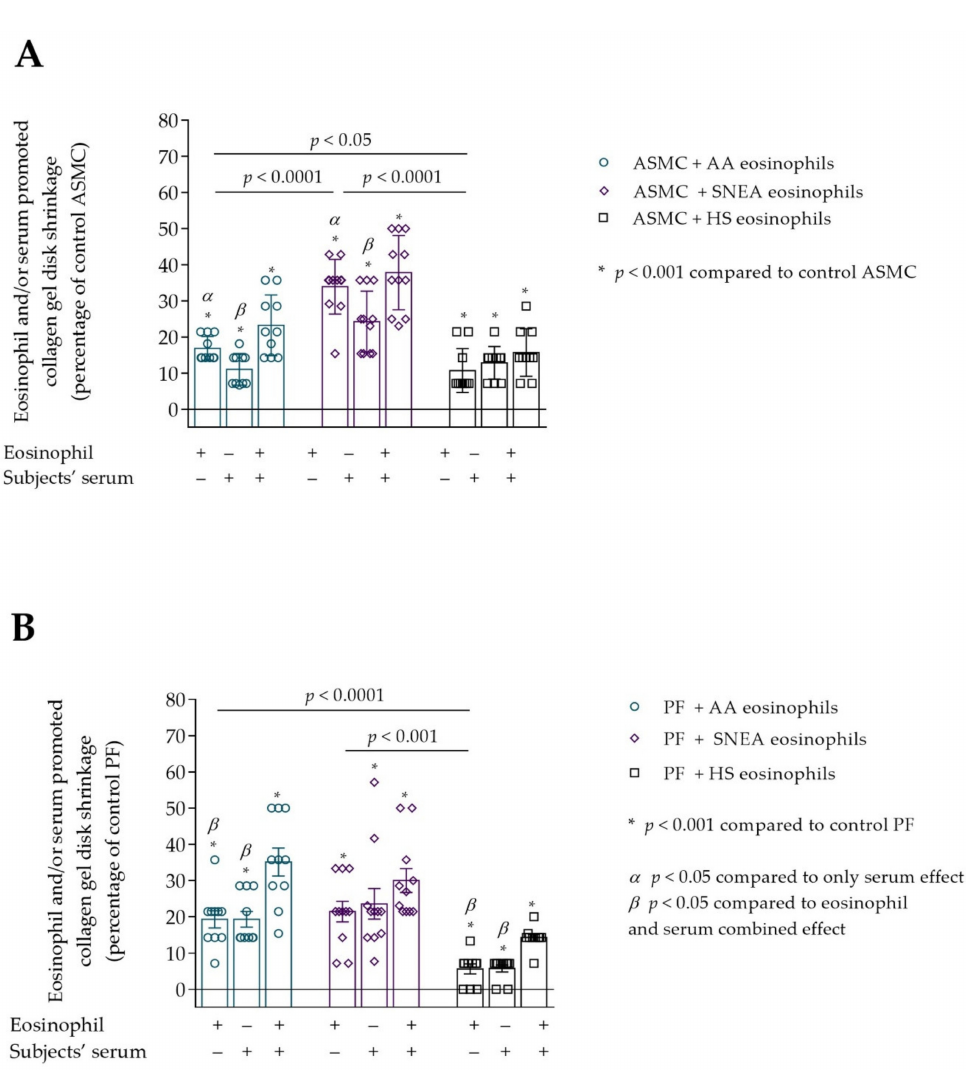
Figure 5. ( A )—The effect of subjects’ eosinophils and/or serum on the ASMC-induced collagen gel disk shrinkage; ( B )—The effect of subjects’ eosinophils and/or serum on the PF-induced collagen gel disk shrinkage. Data presented as percentage of control cells that were not incubated with eosinophils, as mean ± SEM. Added blood serum of each